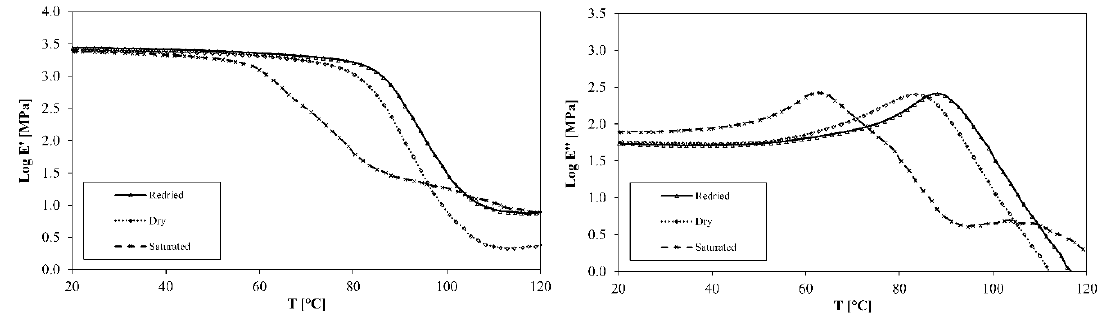
Figure 8. Temperature sweep for glass transition temperature determination for initial (dry); saturated; and redried. ( Left ): temperature sweep of tensile storage modulus. ( Right ): temperature sweep of tensile loss modulus.